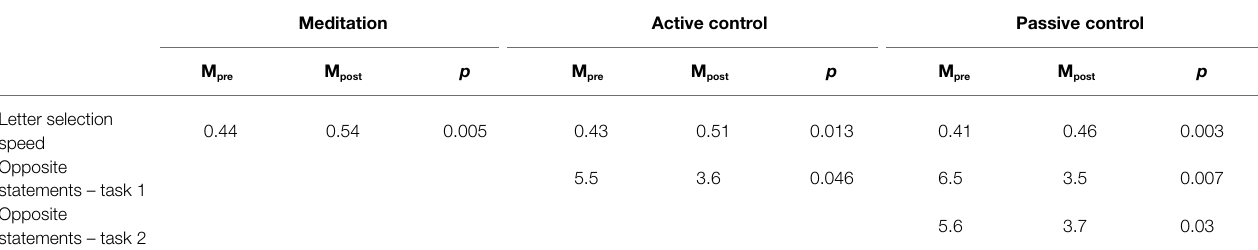
TABLE 3 | Intragroup differences in pre- and post-test measures.